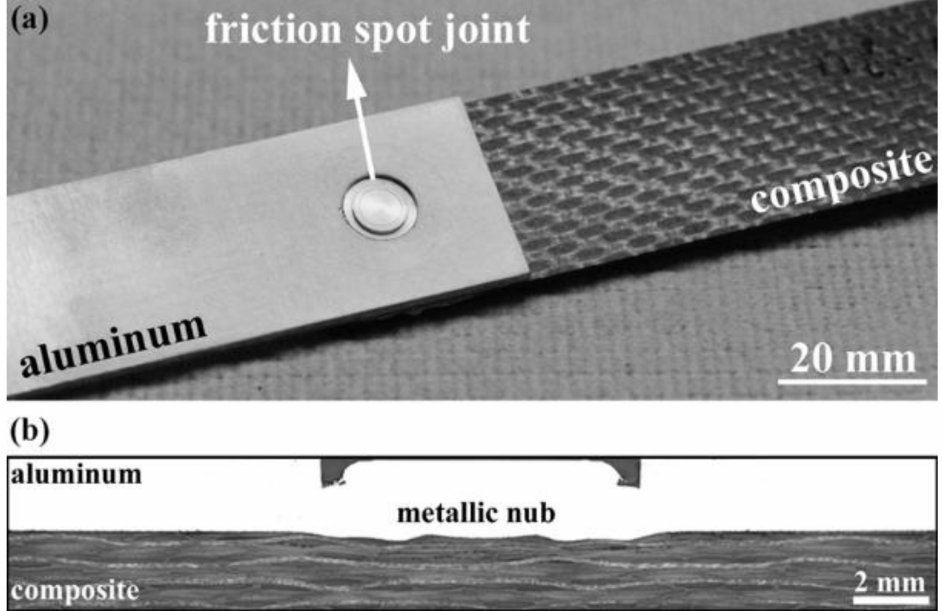
Figure 1. ( a ) Top view of a sound FSp join after consolidation and ( b ) a typical cross-section of an aluminum–composite FSp joint, indicating the metallic nub.